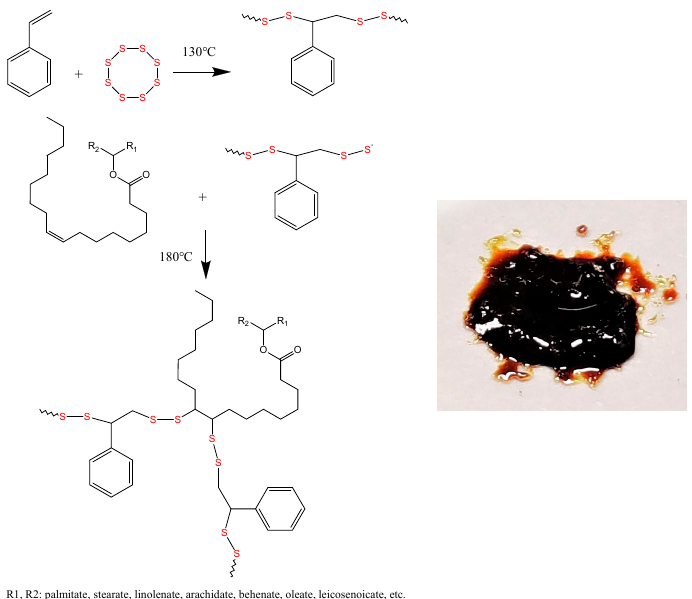
Figure 4. The reaction formula of (sulfur-styrene-peanut oil) (poly(S-Sty-P)) terpolymer and the product photograph.